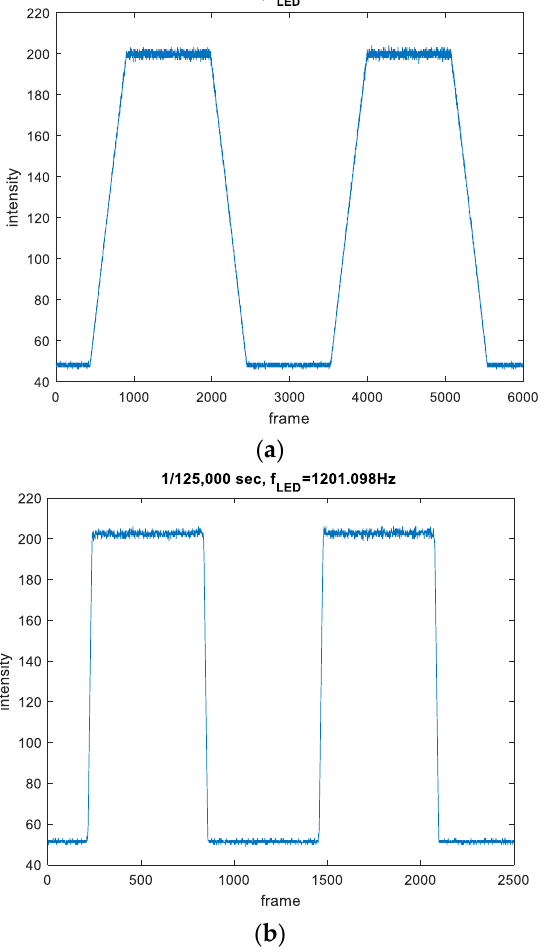
Figure 19. Measurements of camera C3 with equivalent sampling. ( a ) 1/1000 s, ( b ) 1/125,000 s. Table 7. Measurement results of C3, using the equivalent sampling